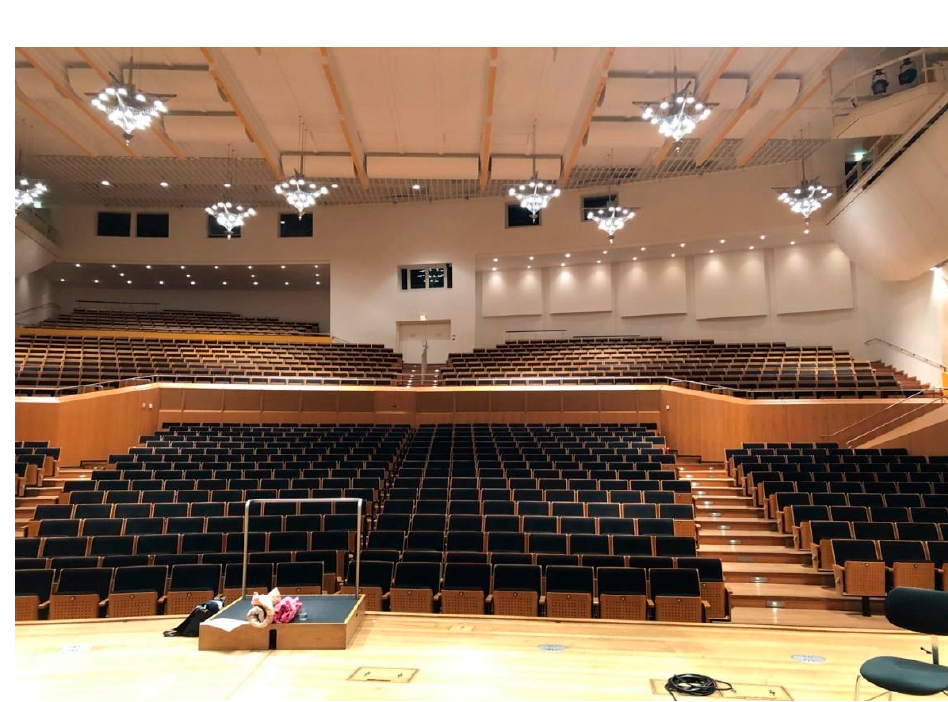
Figure A1. Test location, concert hall of the Bamberg Symphony.